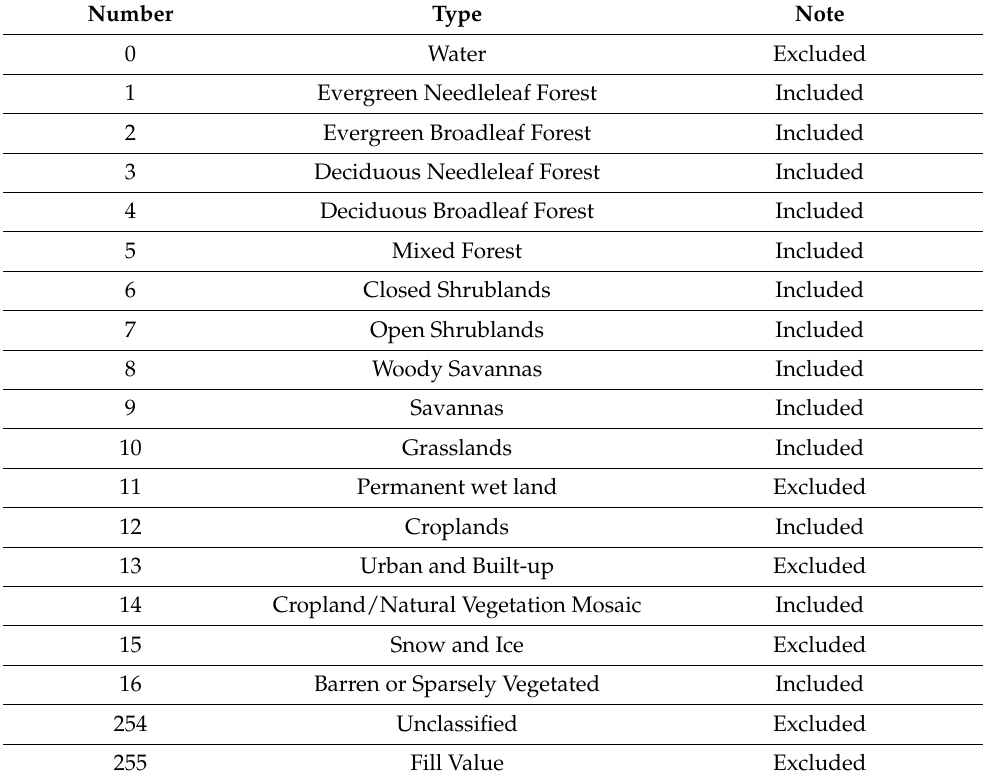
Table 2. GK-2A land cover